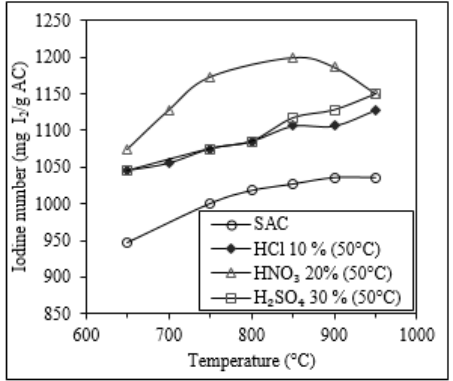
Figure 4. Influence of the reactivation temperature on the iodine number of SAC thermally reactivated during 1 h. Some of these carbons were subjected to a previous acid wash treatment (HCl 10% v / v , HNO 3 20% v / v , and H 2 SO 4 ). SAC was only subjected to thermal reactivation.